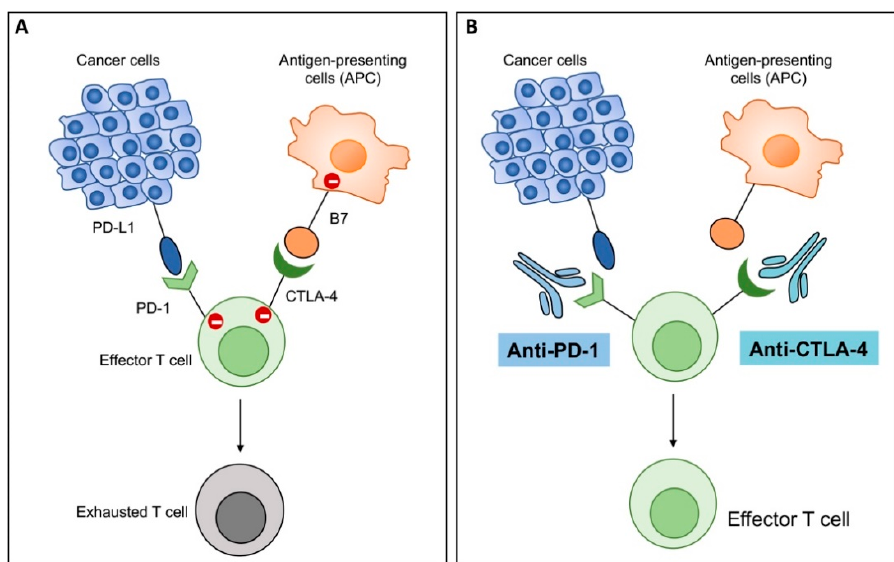
Figure 6. Graphic presentation of mechanism of action of immune checkpoint inhibitors (ICIs). ( A ) T cells express immune checkpoints programmed death 1 (PD-1) and cytotoxic T lymphocyte antigen 4 (CTLA-4), which interact with their corresponding ligands, i.e., programmed death ligand 1 (PD-L1) on cancer cells and B7 molecules on antigen presenting cells (APC), respectively. PD-1:PD-L1 and CTLA-4:B7 interactions send negative signals to immune cells, leading to exhaustion of T cells and no effector activity. ( B ) Antibodies to PD-1 (anti-PD-1) and CTLA-4 (anti-CTLA4) block those interactions and unleash anti-tumor immunity by enhancing activity of effector T cells.